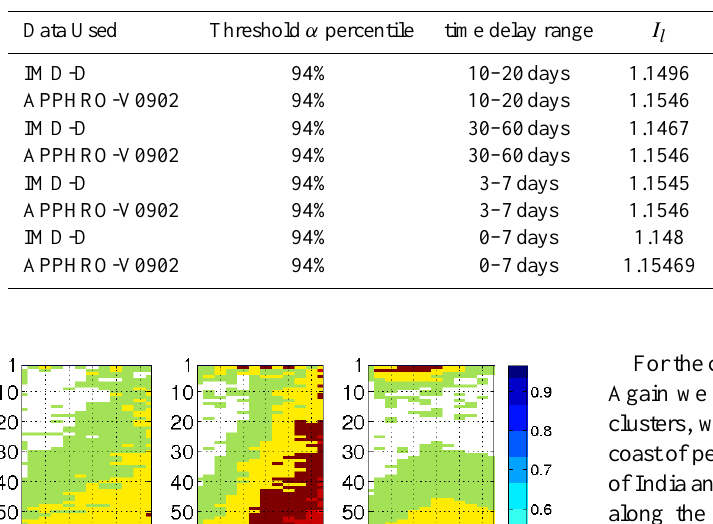
Table 2. Summary of results of the Cluster analysis.